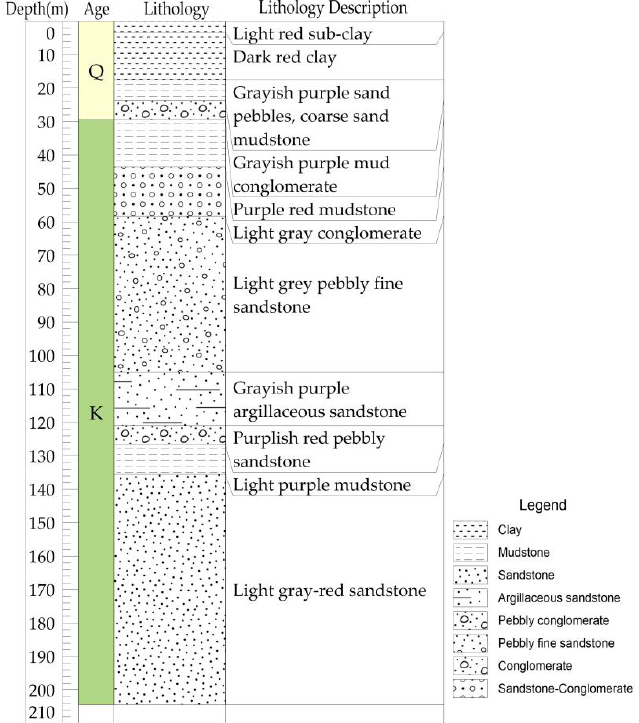
Figure 6. Stratigraphic section of Binxian B21 drill ( modified after internal information).